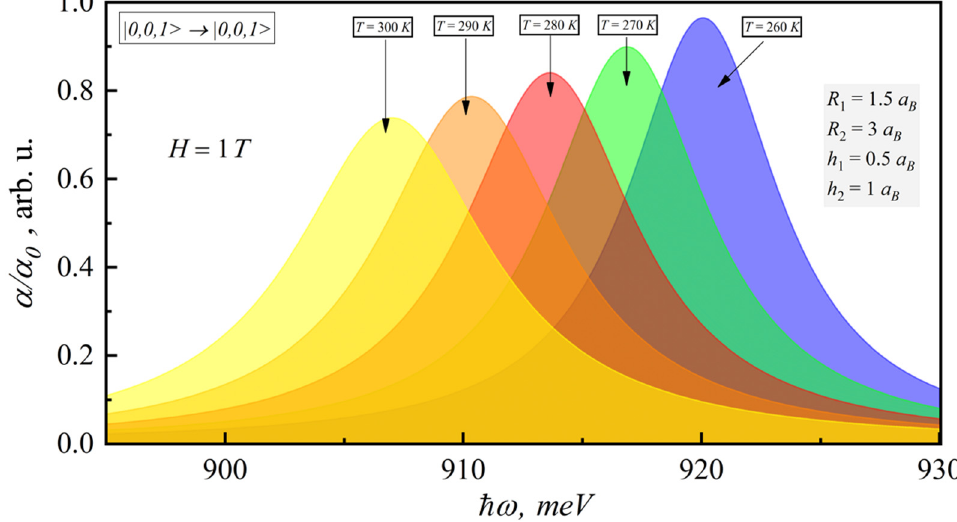
Figure 4. Dependence of room-temperature interband absorption coefficient on photonenergy for different temperatures.